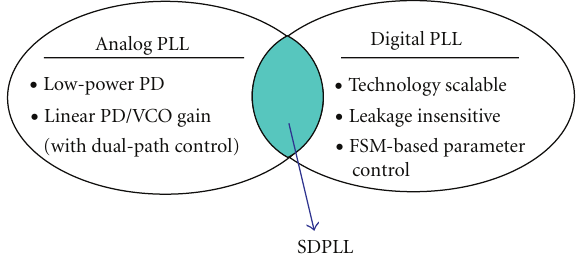
Figure 7: Architecture